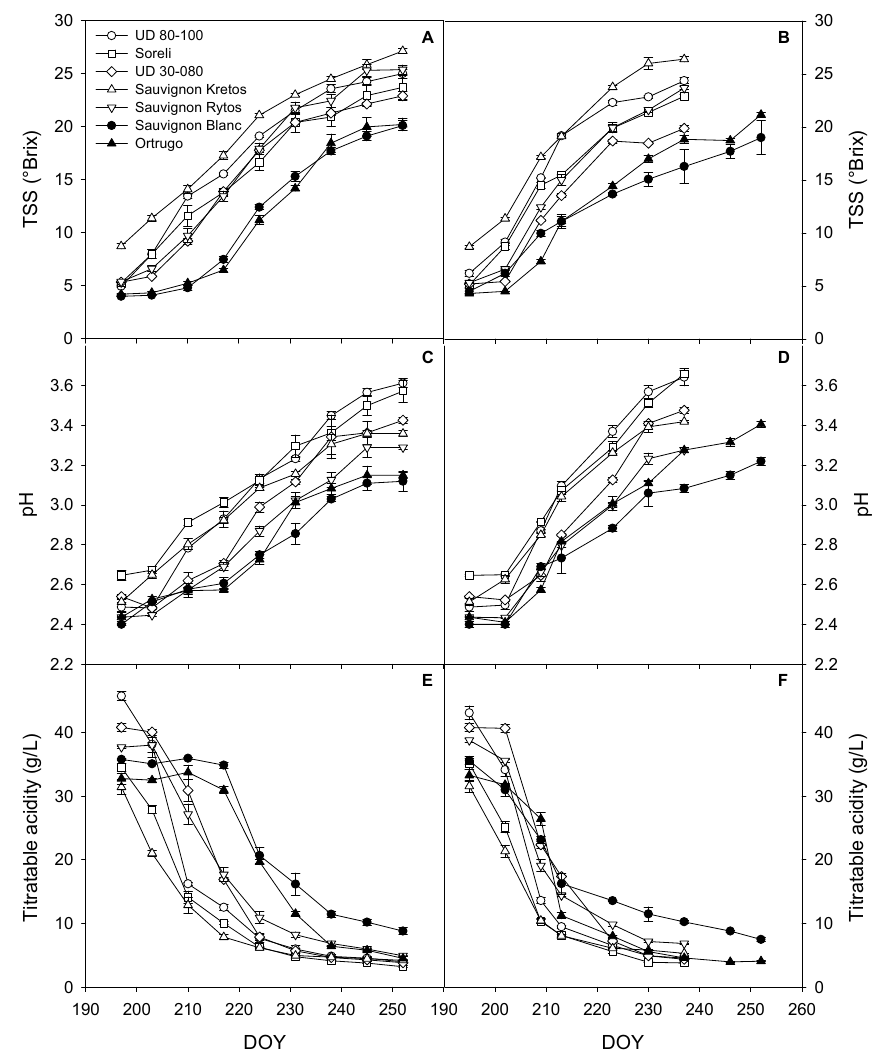
Figure 2. Seasonal evolution of grapes total soluble solids (TSS, panels A , B ), pH ( C , D ) and titratable acidity ( E , F ) in 2019 ( A , C , E ) and 2020 ( B , D , F ) for 5 pathogens-resistant varieties (white symbols) and 2 reference V. vinifera cultivars (black symbols). Each point represents the average of three replicates ± SE. DOY = day of year.